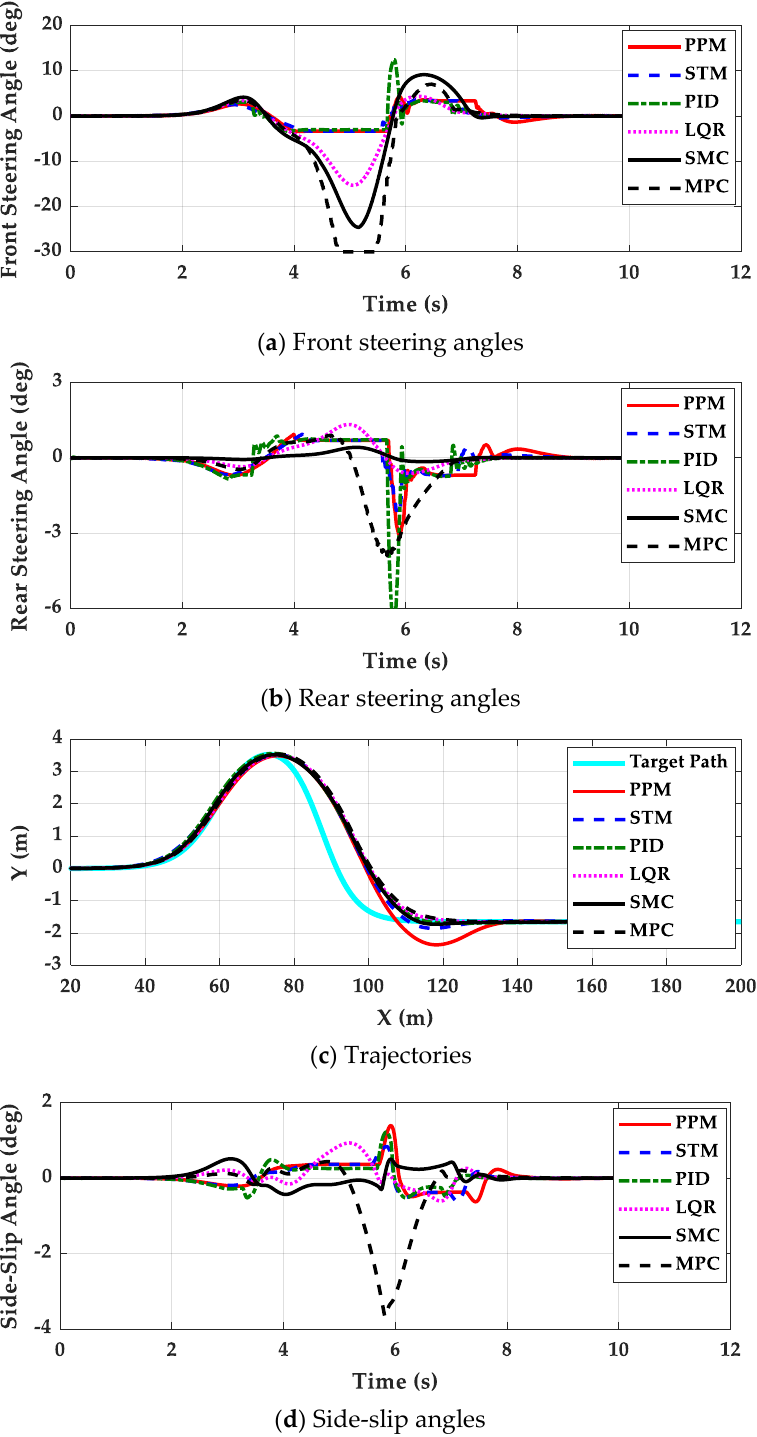
Figure 9. Simulation results of each controller for 4WS vehicle on low- µ road obtained from the third set of